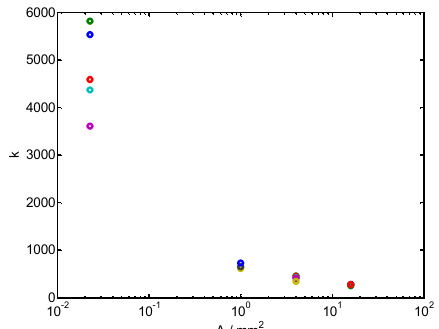
Fig.19: Mean value of the geometry factor k (1 kHz – 10 kHz) for gold electrodes with different surfaces area. This different behavior for the very small electrode suggests an increasing influence of parasitic elements. Compensating for parasitic elements requires that they are independent on the experimental condition and that a suitable model is used which needs to be tested individually for all electrode geometries.